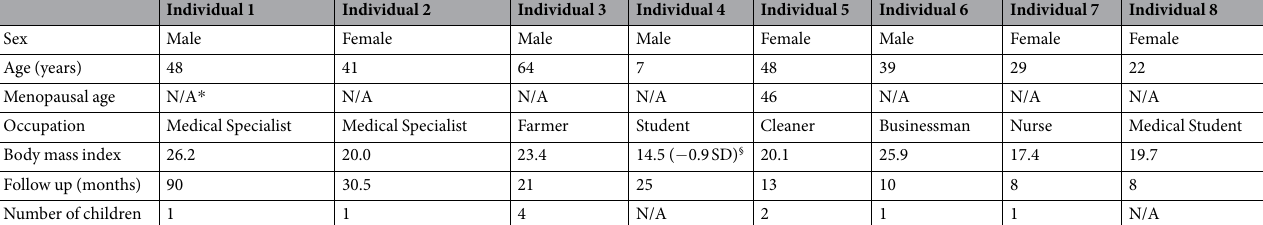
Table 1. Clinical and Demographic Data of the Individuals Who Are Homozygous for p.Ser267Phe in SLC10A1 . * N/A: not applicable. § The normal body mass index range according to Chinese standards for individual 4 (7 years and 9 months old) is 13.0–20.6 23